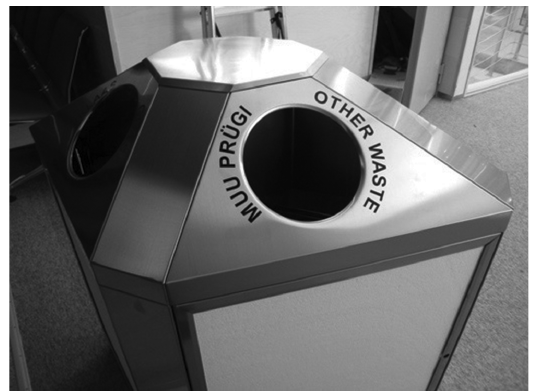
Fig. 9. Amount of waste at Tallinn Airport (Keskküla